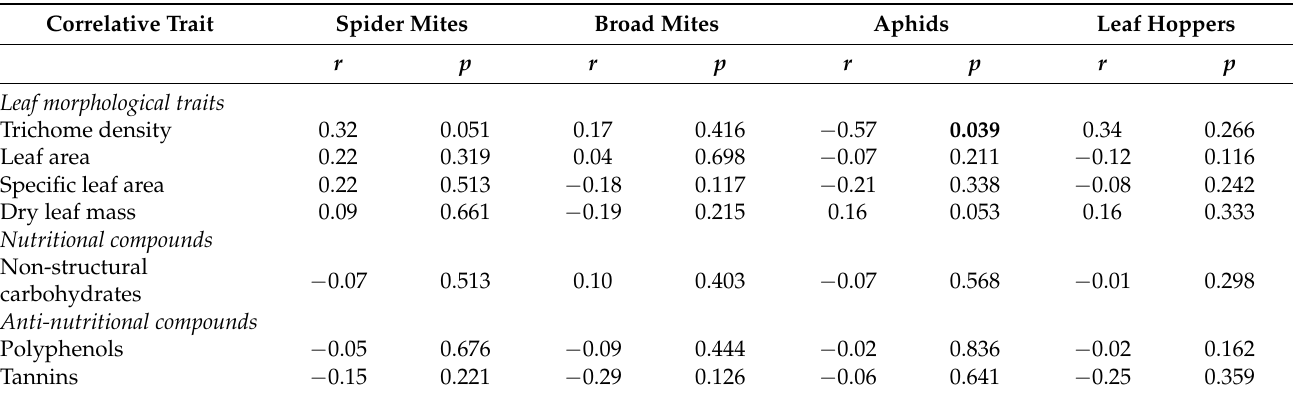
Table 3. Pearson correlations ( r ) testing for relationships between leaf morphological and phytochem- ical traits. Significant values are in bold .